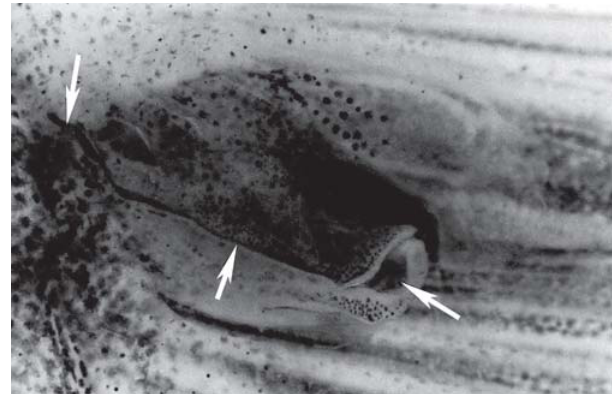
Fig. 80. Mimagoniates microlepis , male, USNM 279876, 51.7 mm SL; central basal region of caudal fin adjacent to caudal peduncle (at left), lateral view, left side, anterior at right. Illustrates external features of caudal organ including fin-ray pump chamber. Arrow at left indicates anterior intake opening, middle arrow points to lateral slit in pump chamber, and arrow at right designates posterior exit opening. Modified dorsal lobe caudal-fin squamations translucent and difficult to see but represented by light circular “ghost” images over the dorsal surface of pump chamber and posterior to chamber. Fig. 83. Mimagoniates microlepis , large adult male, USNM 249876, 59.3 mm SL; pelvic-fin rays, ventral view, left